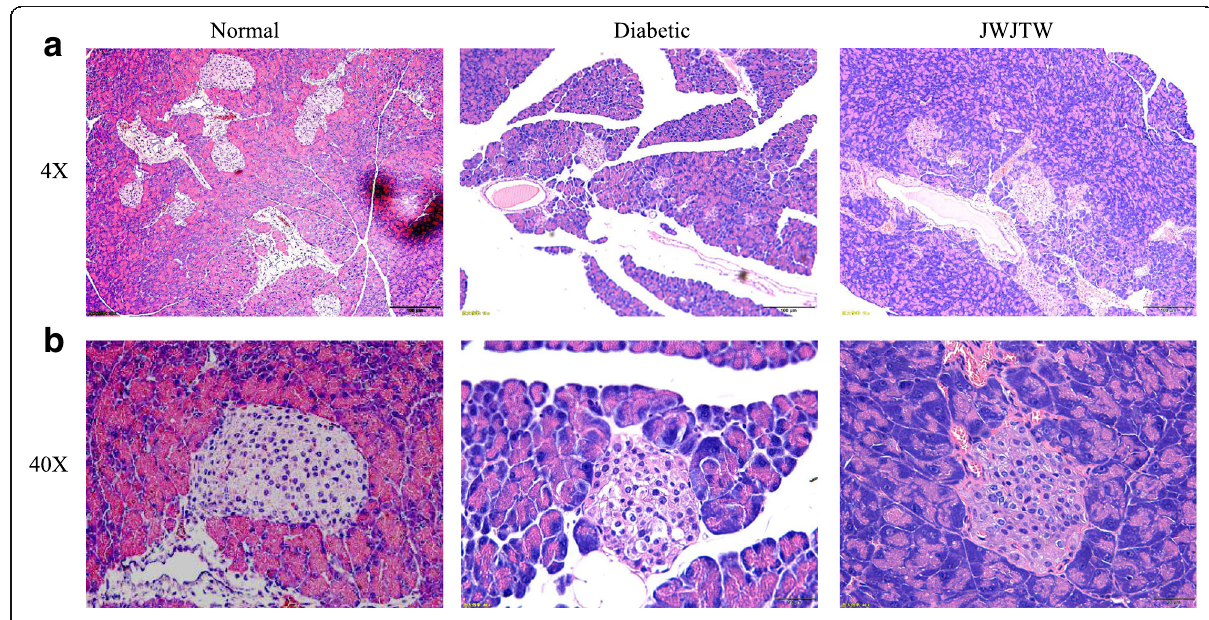
Fig. 6 Effects of JWJTW on pancreatic islet number and structure in diabetic rats. a Representative hematoxylin and eosin staining of pancreatic islets, 4×. b Representative hematoxylin and eosin staining of pancreatic islets, 40